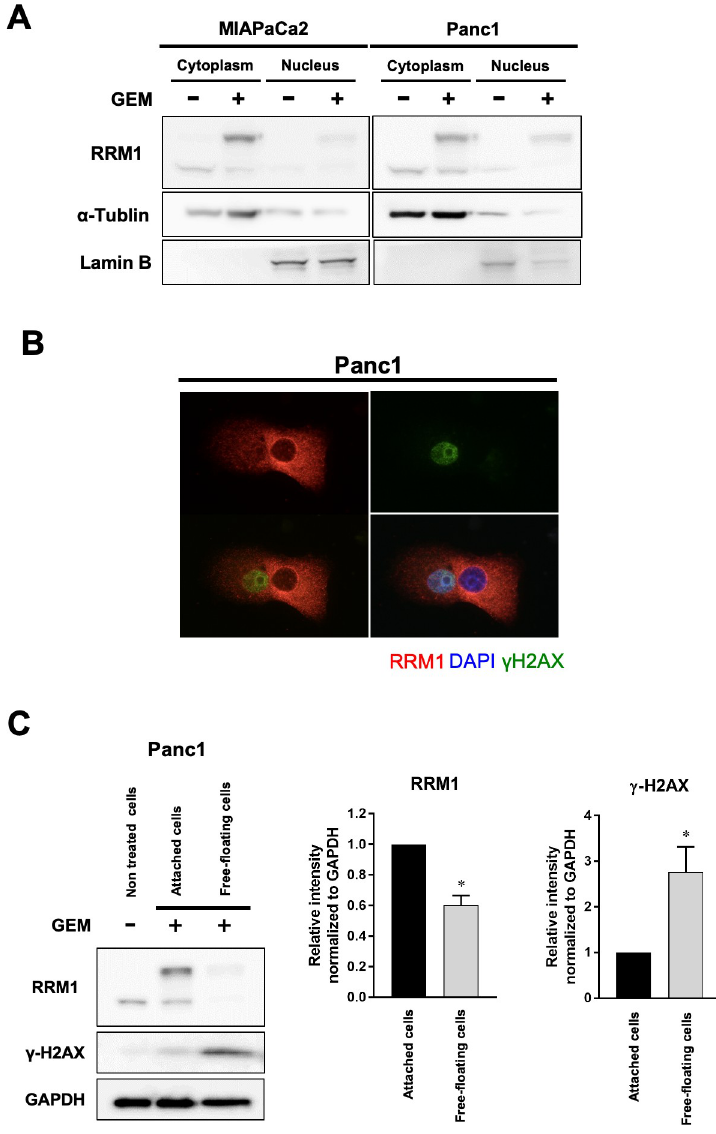
Fig 5. Increased RRM1 expression in pancreatic cancer cell cytoplasm is associated with drug resistance to gemcitabine. (A) Effects of gemcitabine on RRM1 expression levels in cytoplasmic and nuclear fraction in MIAPaCa2 and Panc1 cells. RRM1 activation induced by gemcitabine was predominantly observed in the cytoplasm. (B) Evaluation of RRM1 expression on exposure to gemcitabine. Notably, RRM1 activation in the cytoplasm was confirmed in those cells tolerating gemcitabine exposure. In contrast, RRM1 activation was not observed in cells with severe DNA damage induced by gemcitabine. (C) Cancer cells were fractionated into either still attached on the plate or free-floating in the medium after gemcitabine treatment for 72 hours. The latter showed marked γ -H2AX activation. Indeed, RRM1 activation in the cytoplasm was confirmed only in attached and viable cells to tolerate gemcitabine-induced DNA damage. On the other hand, cancer cells undergoing apoptosis increased DNA damage and significantly downregulated RRM1 expression. The graph depicts averaged intensity of bands representing γ - H2AX and band shifted RRM1 comparing to original RRM1 intensity without gemcitabine, normalized to the intensity of bands representing GAPDH. Error bars represent mean ± SD. � p < 0.05 vs attached viable cells after gemcitabine exposure. The Western blotting assay was performed in